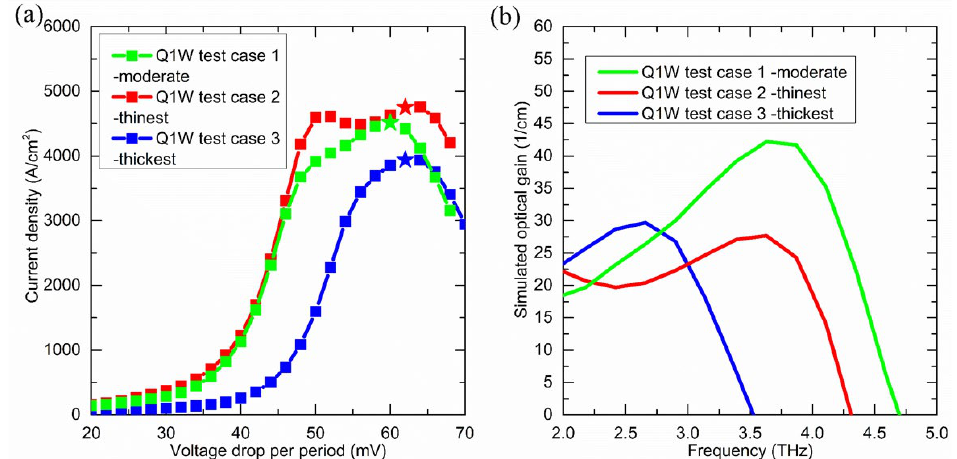
Figure 4. Simulation performance of three Q1W designs at 100 K. ( a ) JV curves at 100 K. ( b ) Optical gain at 100 K. Test case 1: 1.7 (25%Al)/ 8 (7%Al)/11.4 (GaAs), test case 2: 1.7 (25%Al)/ 7 (7%Al)/11.4 (GaAs), test case 3: 2.7 (25%Al)/ 7 (7%Al)/10.4 (GaAs). Layer thickness is shown in nm, and numbers in bold indicate barriers. The underlined layers are averagely doped to achieve sheet density of 3 × 10 10 cm −2 . Test cases 1–3 failed during subsequent investigation conducted in the next section, which studies high-energy parasitic energy levels.